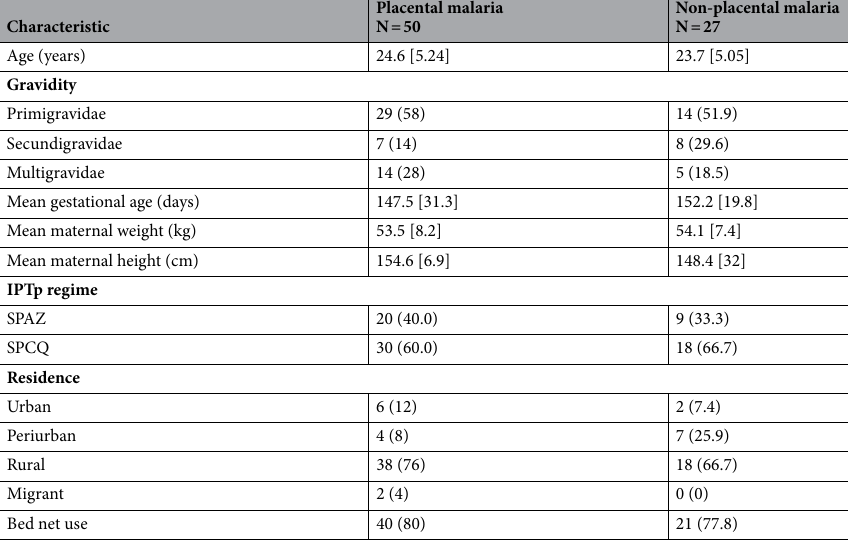
Table 1. Characteristics of study participants. Data shown as mean [standard deviation], or number (%). IPTp intermittent preventive treatment in pregnancy, SPAZ sulphadoxine-pyrimethamine and azithromycin, SPCQ sulphadoxine-pyrimethamine +